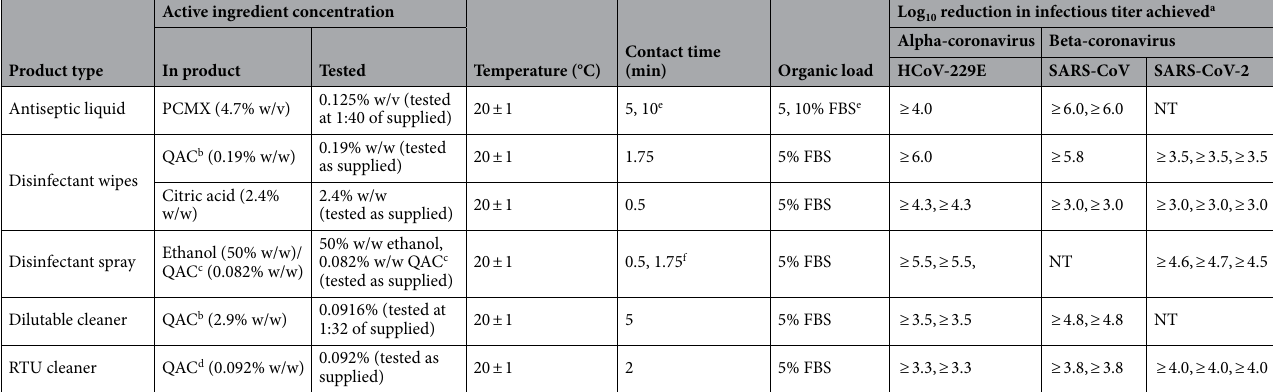
Table 3. Virucidal efficacy of formulated microbicides tested per ASTM E1053-20 Standard against HCoV- 229E, SARS-CoV, or SARS-CoV-2 dried on a glass surface in the presence of an organic load. In all cases, one technical replicate was performed per data point. Abbreviations used: FBS, fetal bovine serum; HCoV-229E, human coronavirus strain 229E; NT, not tested; PCMX, p -chloro- m -xylenol; QAC, quaternary ammonium compound; RTU, ready to use; SARS-CoV, severe acute respiratory syndrome coronavirus; SARS-CoV-2, severe acute respiratory syndrome coronavirus 2; w/v, weight-to-volume; w/w, weight-to-weight. a Where multiple values are displayed, this reflects the testing of multiple independent lots of the formulated microbicide. b Alkyl (50% C14, 40% C12, 10% C16) dimethyl benzyl ammonium chloride. c Alkyl (50%